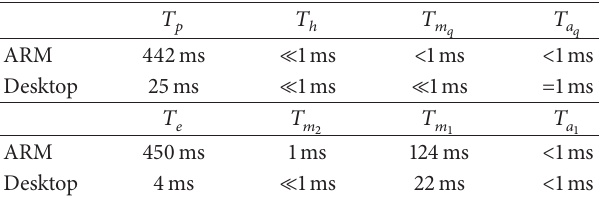
Table 4: Detailed performance parameters.